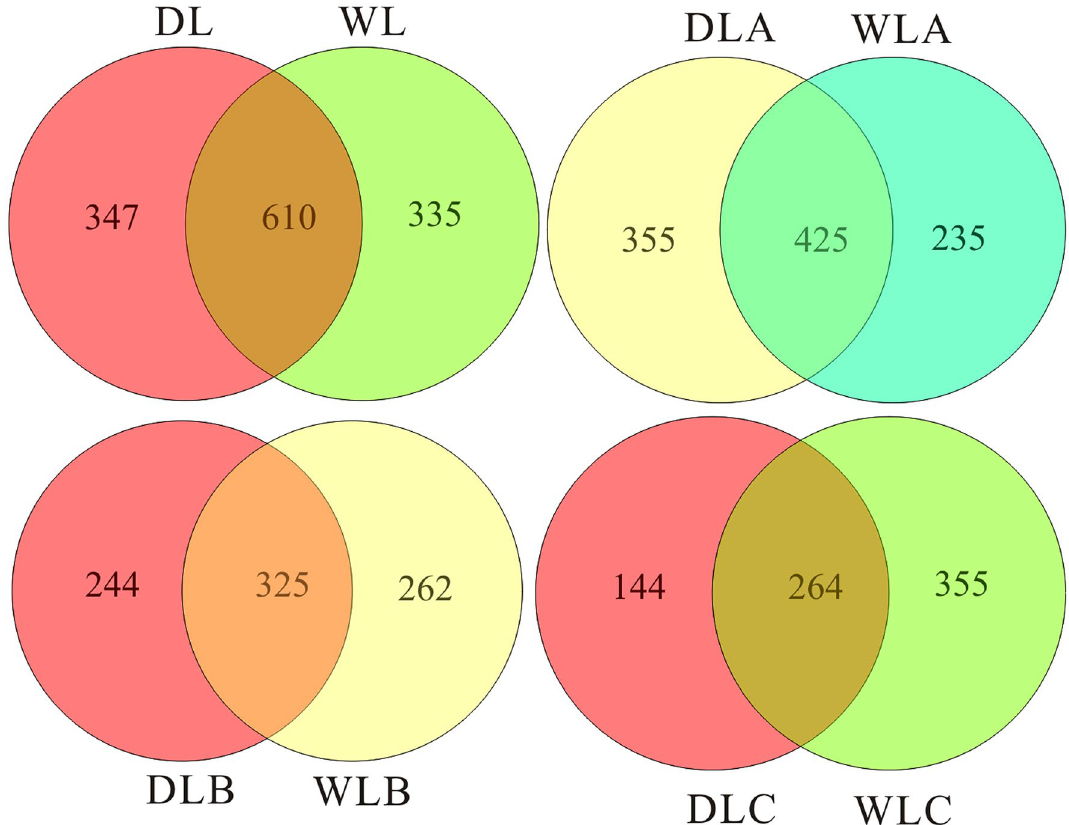
Figure 3. A Venn diagram with shared and unique OTUs of WL Reservoir and DL